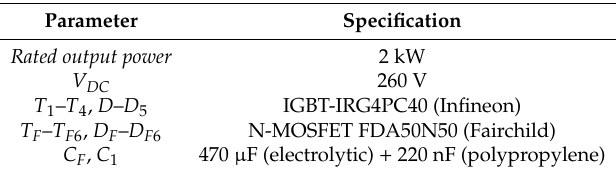
Table 3. PQRDCLI